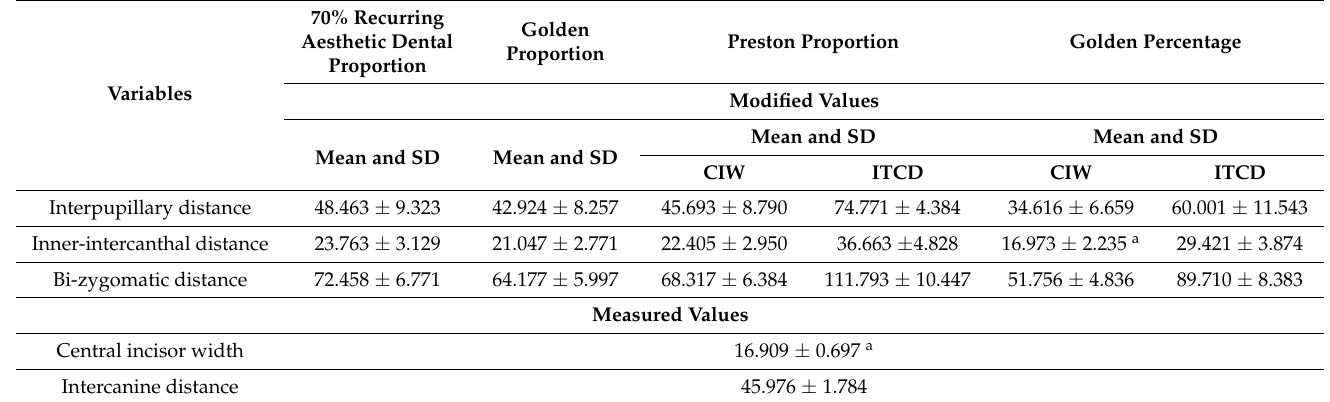
Table 8. The comparison of modified central incisors width and intercanine distance using dental proportions by horizontal facial proportions with measured width of central incisors and intercanine distance-mixed group ( n = 230).